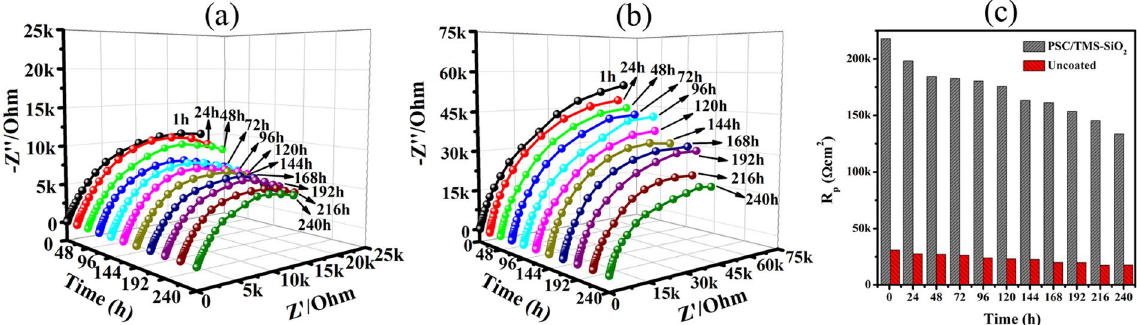
Figure 8. Nyquist plots of ( a ) uncoated 316SS and ( b ) PSC/TMS-SiO 2 coating exposed to 3.5% NaCl for 240 h, ( c ) change in R p during 240 h of exposure of uncoated and coated samples with thier